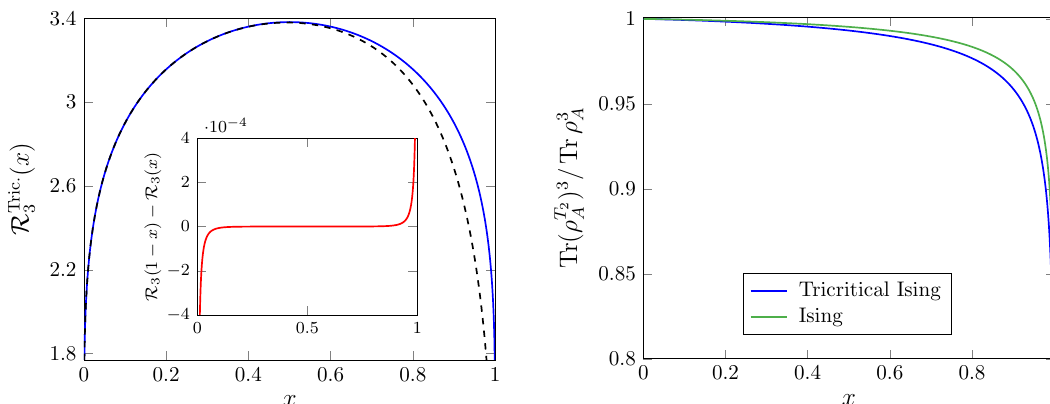
and Tr ( ρ T 2 ) N for N = 3 in the Tricritical Ising CFT. Figure 3 . Analysis of the moments Tr ρ N A A In the left panel, we plot the function R ( x ) , introduced in eq. (5.14), by replacing Tr ρ 3 with 3 A its expansion in sphere conformal blocks, eq. (5.6), which we truncate at level L = 6 . On the other hand, the dashed line has been computed by decomposing Tr ρ 3 in N = 3 orbifold conformal A blocks and substituting their small x representation in eq. (3.29). In the inset of left panel, we check the crossing symmetry of the continuous blue line. In the right panel, we study the ratio Tr ( ρ T 2 ) 3 / Tr ρ 3 . The curve has been obtained by applying the sphere conformal block expansions A A for Tr ρ 3 and Tr ( ρ T 2 ) 3 of eqs. (5.6) and (5.12), up to level L = 6 . As a comparison, we also plot the A A result presented in figure 2 for the Ising CFT. The sphere conformal blocks have been computed until level L 0 = 8 using the elliptic recursion of eq.